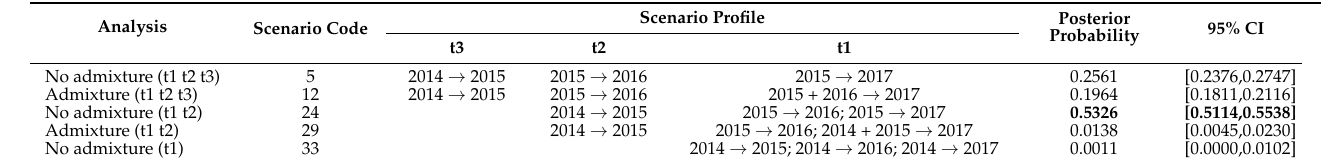
Table 6. Posterior probabilities of the five best scenarios inferred in DIYABC Analysis.